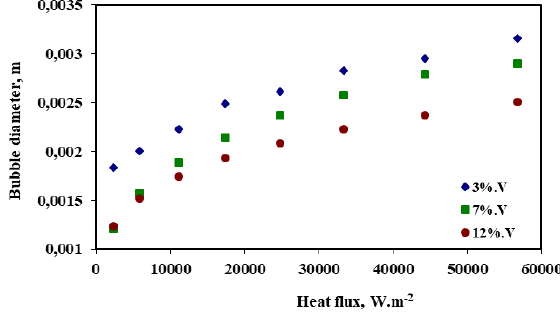
Figure 6: Bubble diameter measured for water-ethanol solution in different heat fluxes.